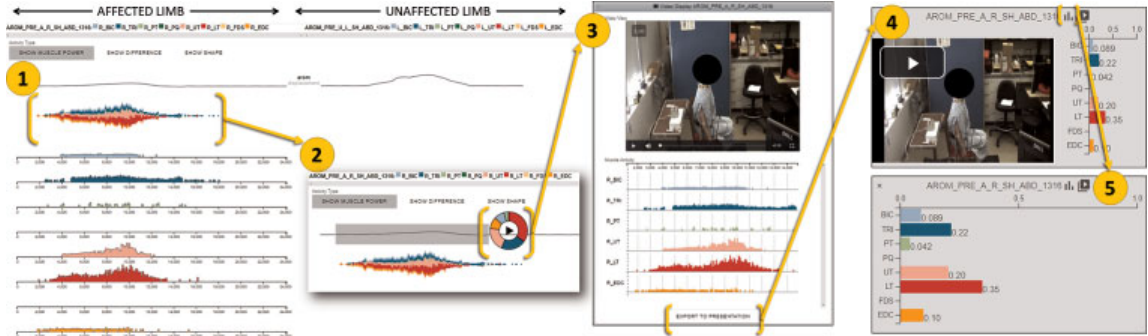
Fig. 1 The Motion Browser data extraction method. 1. The Motion Browser displays the synchronized video, kinematics, and electromyography (EMG) data for the patient ’ s affected and unaffected limbs for each movement performed. 2. The user selected segments of interest based on examining the video clips to fi t selection criteria. Selected segments included all EMG data corresponding to the movement recorded in that video segment. 3. The Motion Browser isolated the motion data for that segment of interest. 4. The Motion Brower displayed a bar chart depicting thefraction ofeach muscle ’ s activation relative tothetotal measuredactivity in the movement in the segmentof interest. 5. Individual bar values for muscle activation were recorded for results